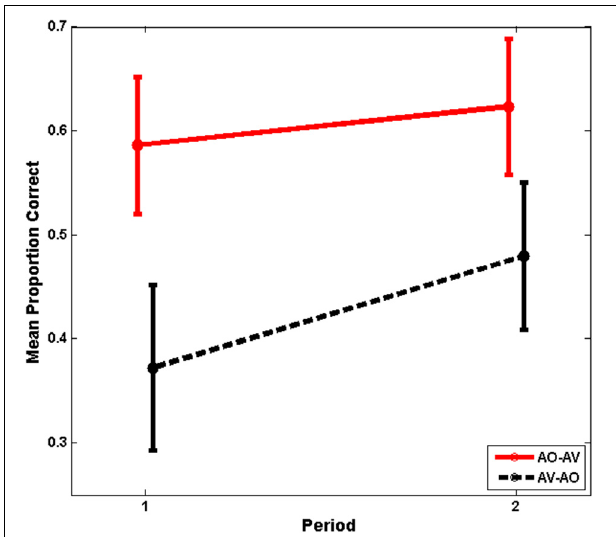
FIGURE 6 | Experiment 1 time series for mean difference scores (test minus training score) with standard errors of the mean per list shown separately for AO-AV vs. AV-AO modality assignments (P1L1, Period 1, List